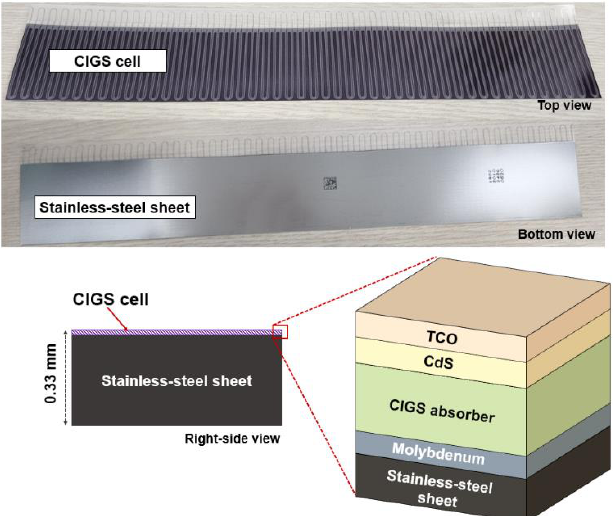
Figure 1. A commercialized copper indium gallium selenide (CIGS) solar cell and its structure. The area comprising the CIGS cell is the active area that converts therapeutic X-ray radiation to electrical signals. TCO and CdS denote transparent conductive oxide and cadmium sulfide, respectively.